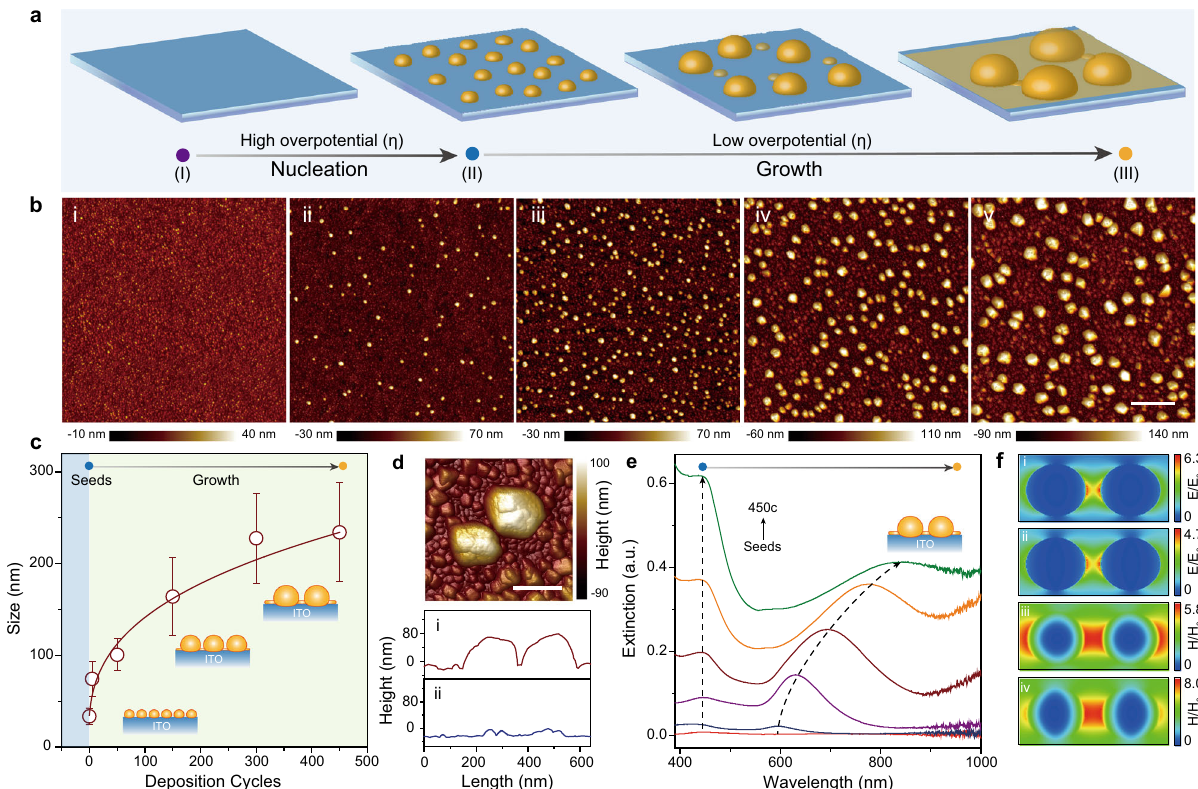
Fig. 1 Seed-mediated electrodeposition of plasmonic Cu nanoparticles. a Schematic illustrating the electrochemical seed-mediated growth strategy. b AFM images of Cu seeds (i) and Cu NPs at different deposition cycles (ii, 5; iii, 50; iv, 150; and v, 300 cycles) (scale bar: 1 μ m). c The correlation between Cu NPs size and deposition cycles. Error bar represents the SE of Cu NPs size. d High-resolution AFM image of Cu NPs (top, 150 cycles, scale bar: 200 nm) and linear scan across Cu NPs dimmer (i) and nearby regions (ii) (bottom). e Ex situ extinction spectra of Cu seeds and Cu NPs at different deposition cycles (5, 50, 150, 300, and 450 cycles). f Top view of electric (i and ii) and magnetic (iii and iv) fi eld snapshots for the near- fi eld con fi nement at the plasmonic resonance wavelengths (i, iii, 450 nm; ii, iv, 690